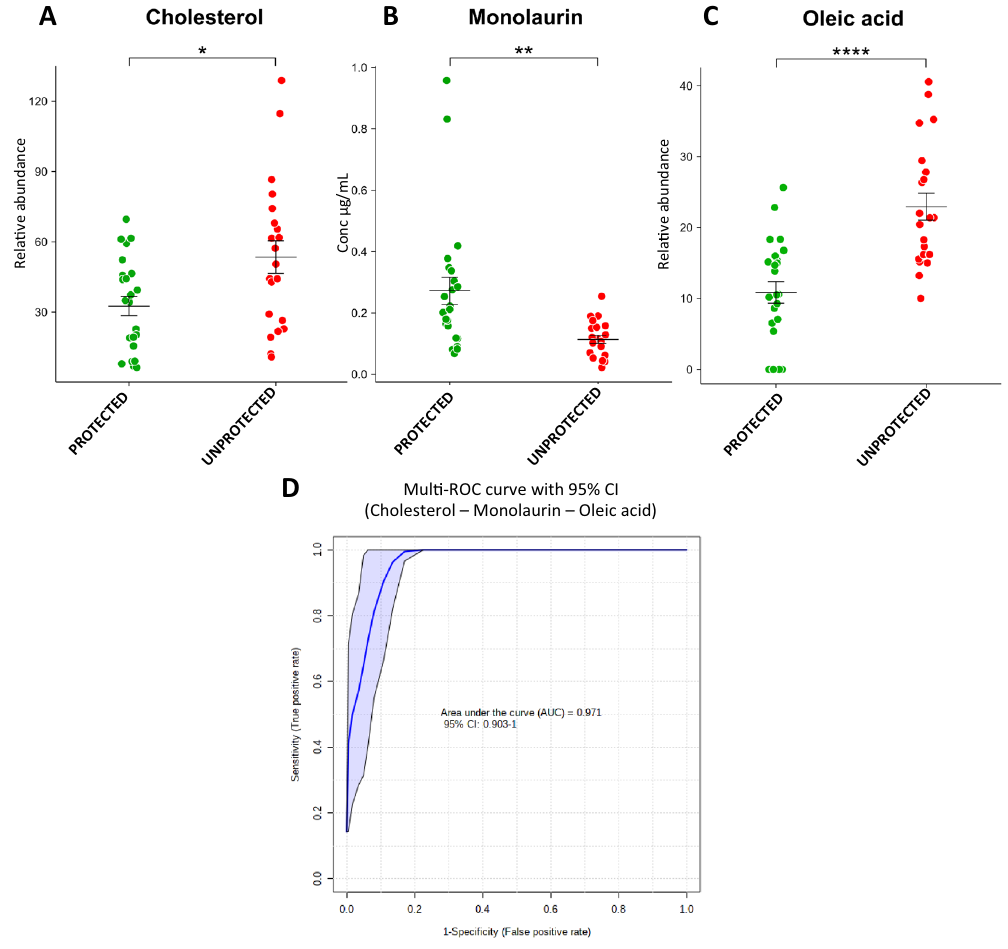
Figure 3. Molecules potentially involved in protecting individuals from SARS-CoV-2 infection or from COVID-19 development. Box-plot of monolaurin ( A ), cholesterol ( B ), and oleic acid ( C ) in protected and unprotected subjects. Combined ROC ( D ) of the three molecules, indicating an AUC of